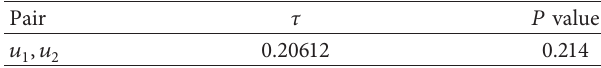
Table 9: Test of independence between marginals using Kendall’s rank correlation.